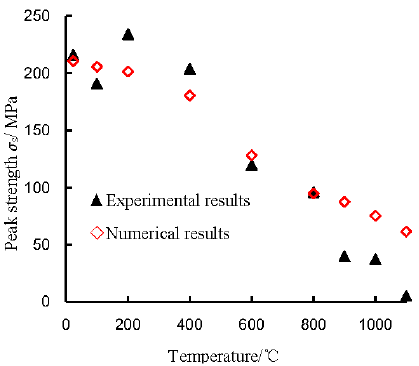
Figure 12. Comparison of the experimental and numerical uniaxial compressive strength of Strathbogie granite at different temperatures [25].